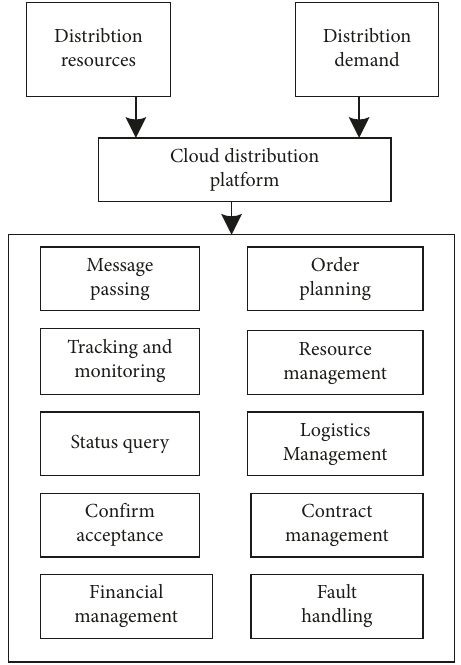
Figure 5: Order management